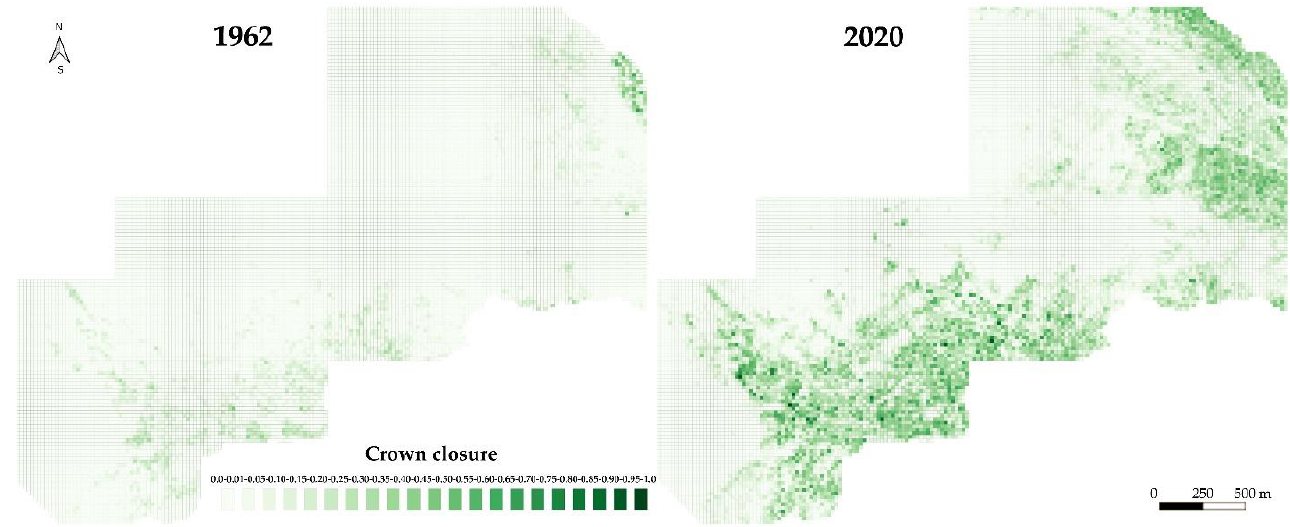
Figure 7. Tree crown closures in 1962 and 2020 on the southern and eastern slopes of a hill with a height mark of 312 m a.s.l., close to Mt. Chernaya (Polar Urals). The share of plots without adult trees (>2 m) almost halved (from 65.4% to 34.5%)